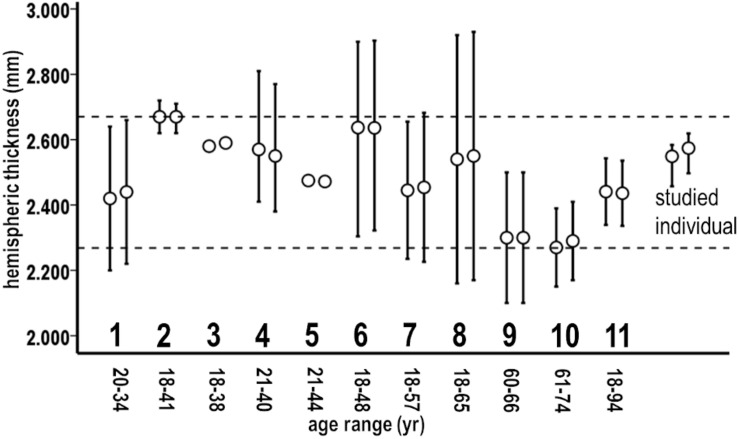
Means and variations of respective left and right cortical hemispheric thicknesses as measured with FreeSurfer in recent studies of 11 normal adult groups (1–11) having indicated age ranges, compared to the studied individual. Variation bars reflect 95% confidence intervals from reported standard deviations (1, 2, 7, 8, 9, and 10), ranges (4 and 6), or root mean square errors (11). Group 3 variations were not reported, and group 5 variations were very small (SD = 0.002). Dashed lines bracket the upper and lower range of means of these groups. Means of thickness maintenances in the studied individual fell within this range. From: group 1 (Tremblay and Deschamps, 2016), 2 (McGuire et al., 2017), 3 (Kang et al., 2012), 4 (Ottino-Gonzalez et al., 2017), 5 (van Erp et al., 2018), 6 (Meyer et al., 2014), 7 (Maingault et al., 2016), 8 (Perlman et al., 2017), 9 (Shaw et al., 2016), 10 (Tremblay and Deschamps, 2016), and 11 (Potvin et al., 2017).